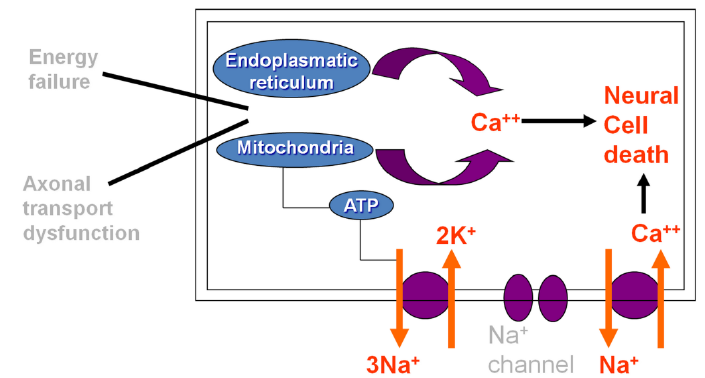
Figure 1. Schematic diagram describing the mechanism of acute oxaliplatin-induced peripheral